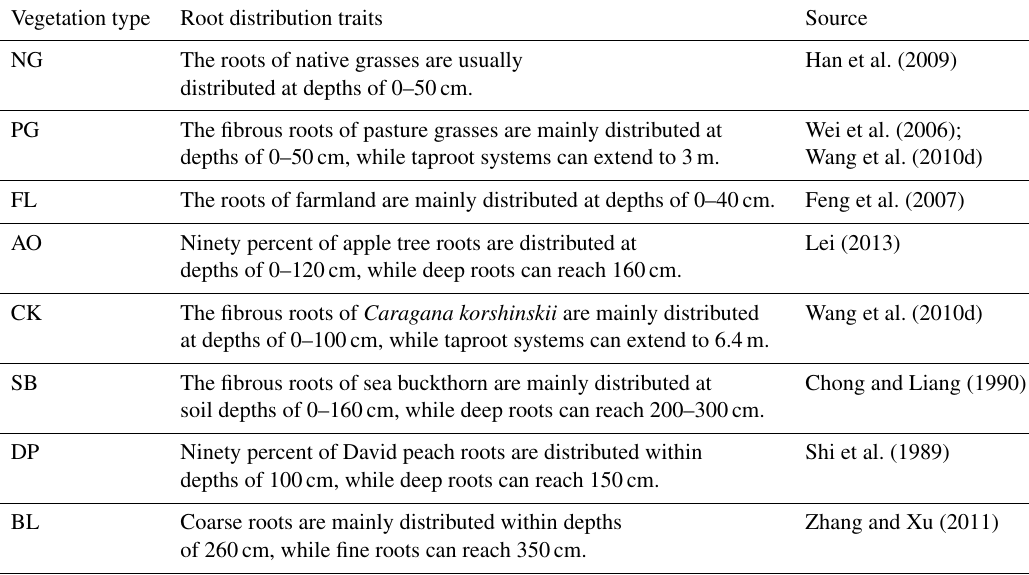
Table 1. Descriptions of the root distributions of the selected vegetation species. Vegetation type Root distribution traits